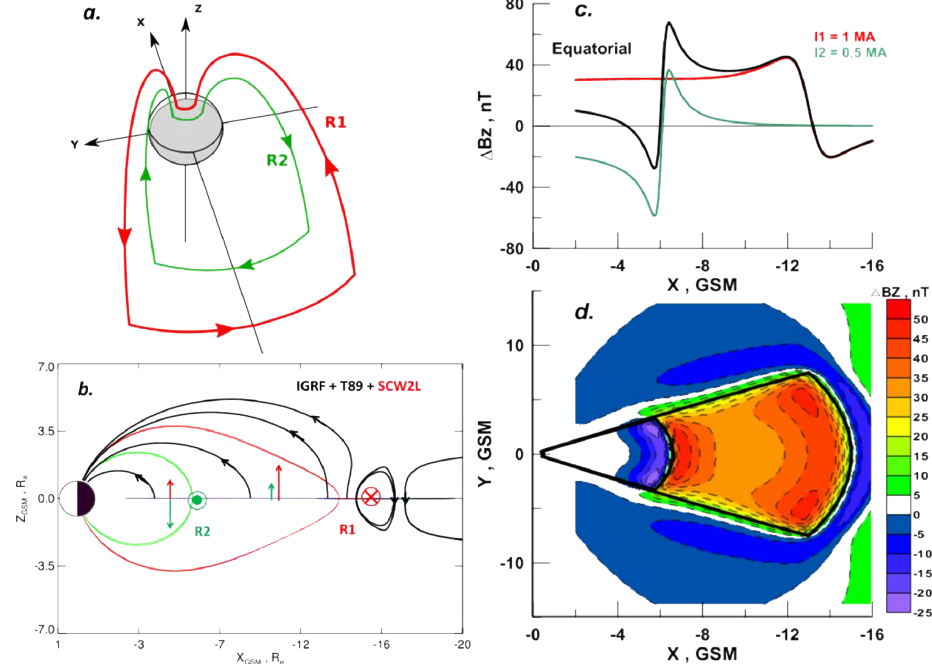
Figure 1. (a) Illustration of the two-loop SCW model (SCW2L); (b) magnetic field-line topology when the background (T89 + IGRF) magnetic field (shown by current-carrying red/green lines) is compared to field lines (black lines) after the addition of SCW2L; (c) partial contribution to (cid:49)B Z perturbations of R1 (red) and R2 (green) SCW components and their sum (black line); (d) (cid:49)B Z distribution in the equatorial plane in the SCW2L model (adapted from Sergeev et al., 2014a). All illustrations are done for a 60 ◦ wide wedge with I 1 = 1MA and I 2 =